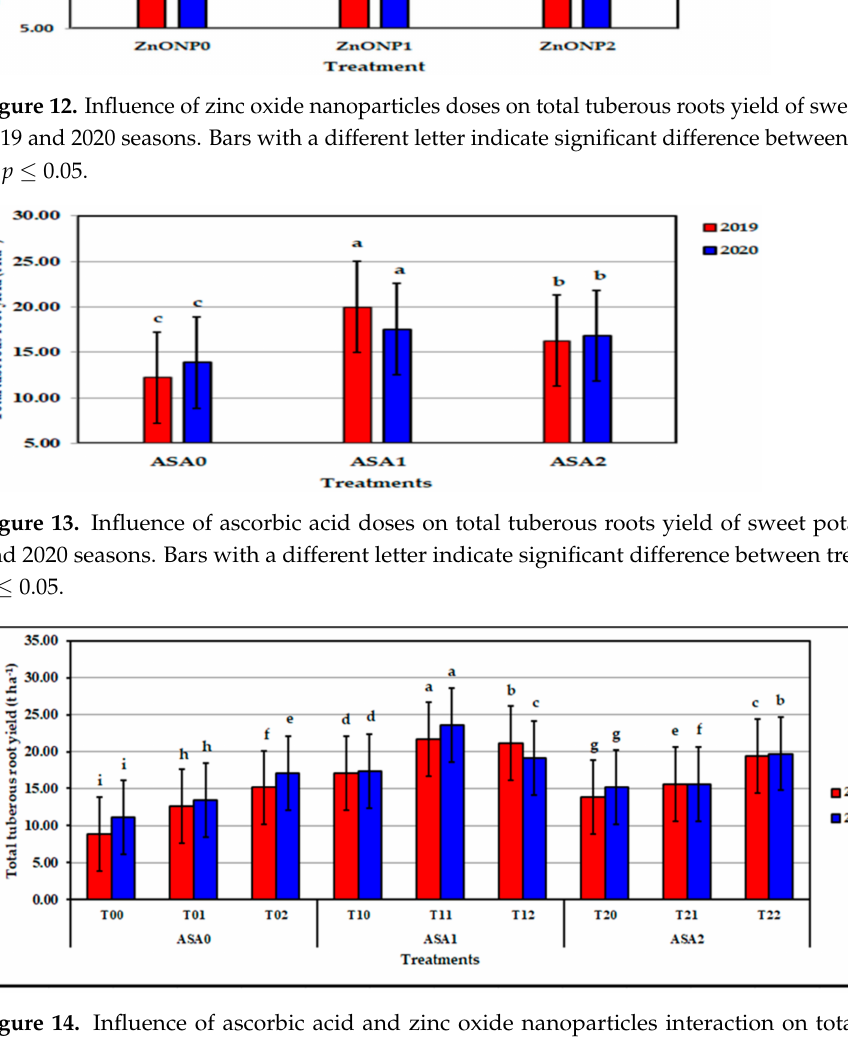
Figure 14. Influence of ascorbic acid and zinc oxide nanoparticles interaction on total tuberous roots yield of sweet potato in 2019 and 2020 seasons. Bars with a different letter indicate significant difference between treatments at p ≤